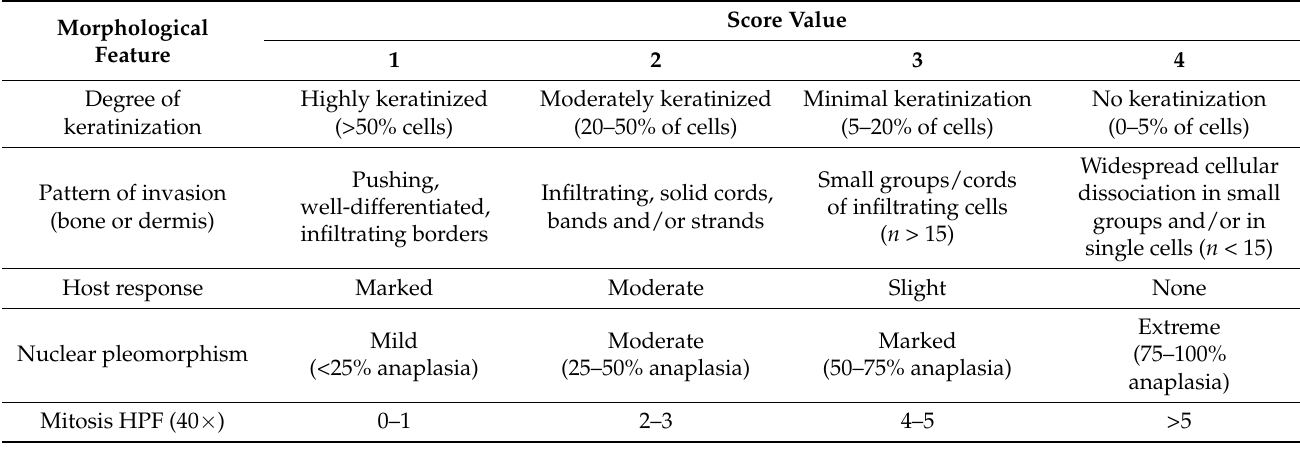
Table 2. Invasive front grading system (IFGS) used in the present study of canine digital squamous cell carcinoma (CDSCC) (adapted from Nagamine et al., (2017) [2] for use in canine oral squamous cell carcinoma). Morphological